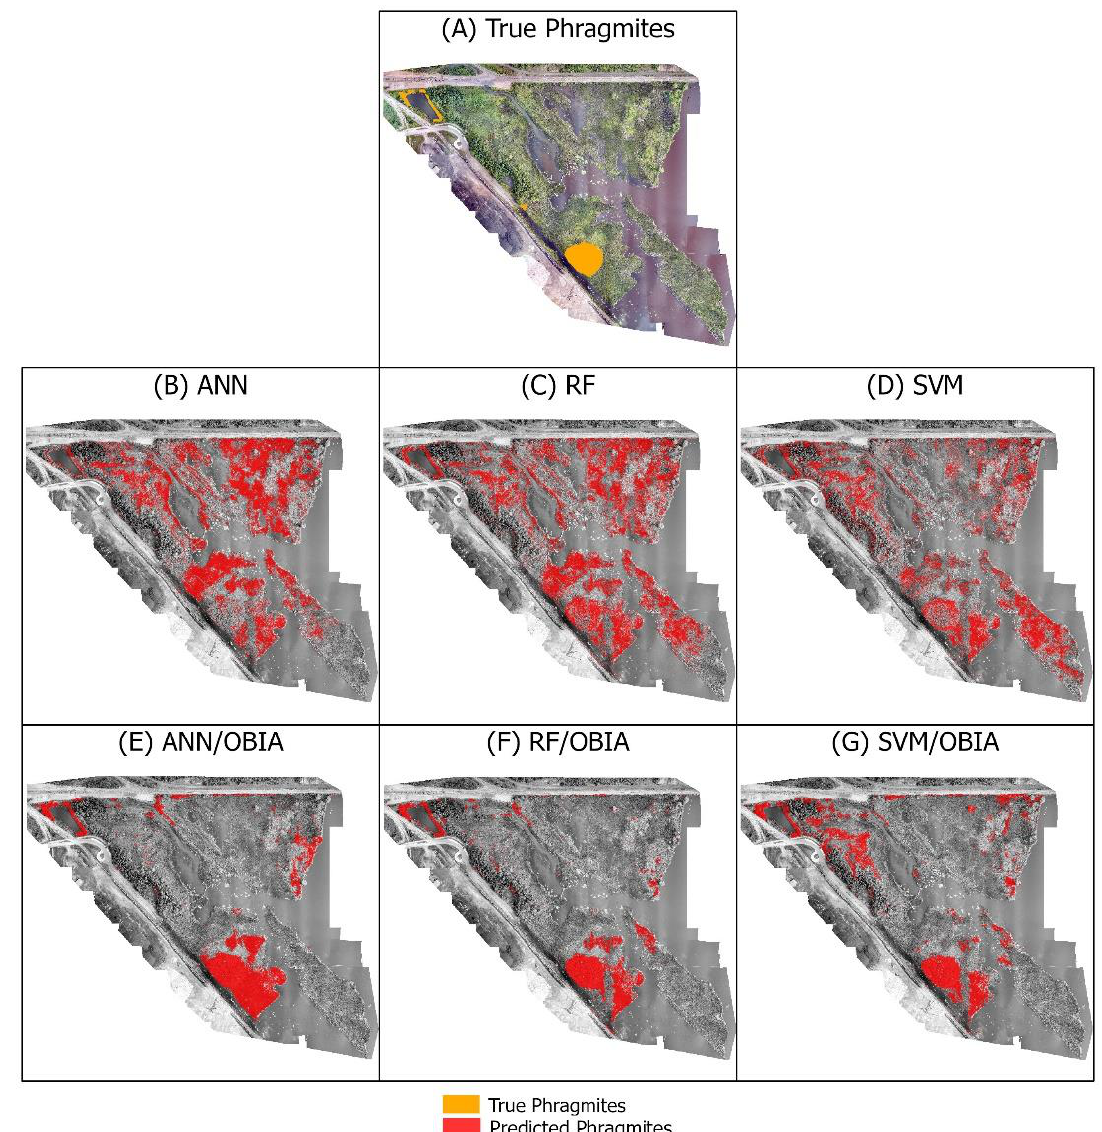
Figure 16. Classification of Phragmites (red) at Grassy Point Park using ( B ) an artificial neural network (ANN), ( C ) random forest (RF), and ( D ) support vector machine (SVM) without the post-ML OBIA rule set. The post-ML OBIA rule set was applied to the ( E ) ANN classification, ( F ) RF classification, and ( G ) SVM classification. Everything not identified as Phragmites was classified as Not Phragmites . The true Phragmites location is provided as a reference (orange).